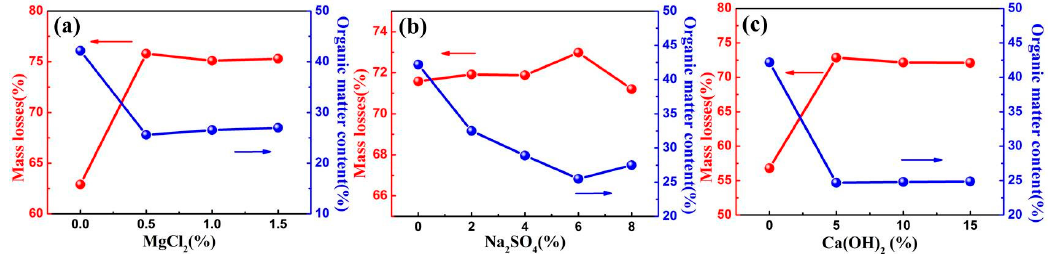
Figure 5 . Effect of the MgCl 2 ( a ), Na 2 SO 4 ( b ), and Ca(OH) 2 ( c ) added amounts on the mass losses and extraction of organic matter.